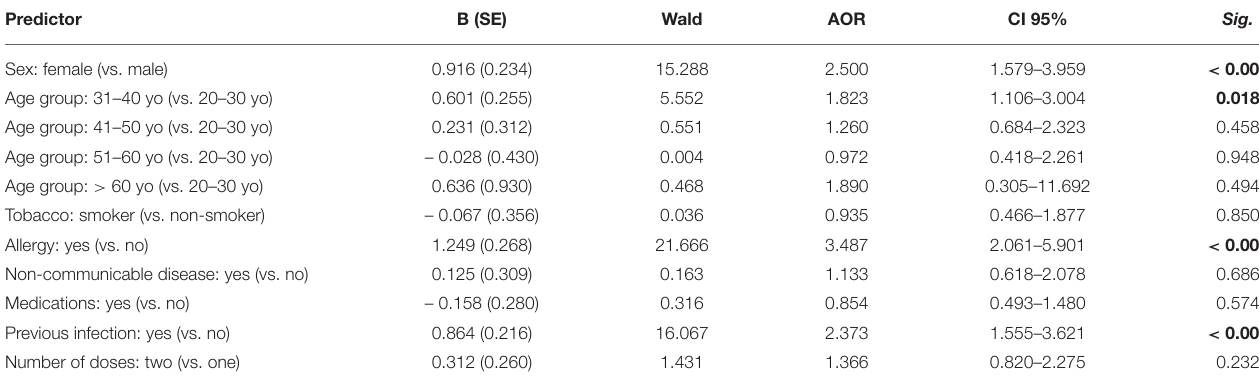
Bold values refer to the statisitically signifcant values which are below